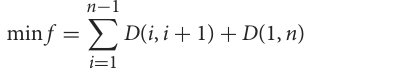
FIGURE2 The optimization process of PSO.